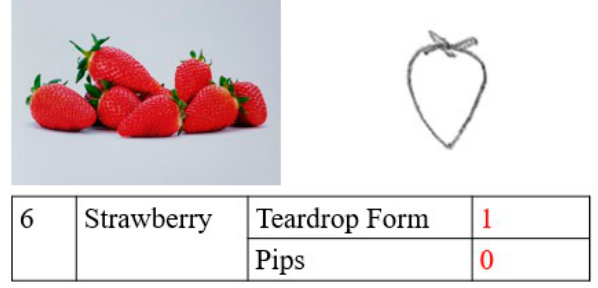
Figure A2. Drawing Task: Model-photo ( left ) and a drawing by a PWA ( right ). The strawberry-item